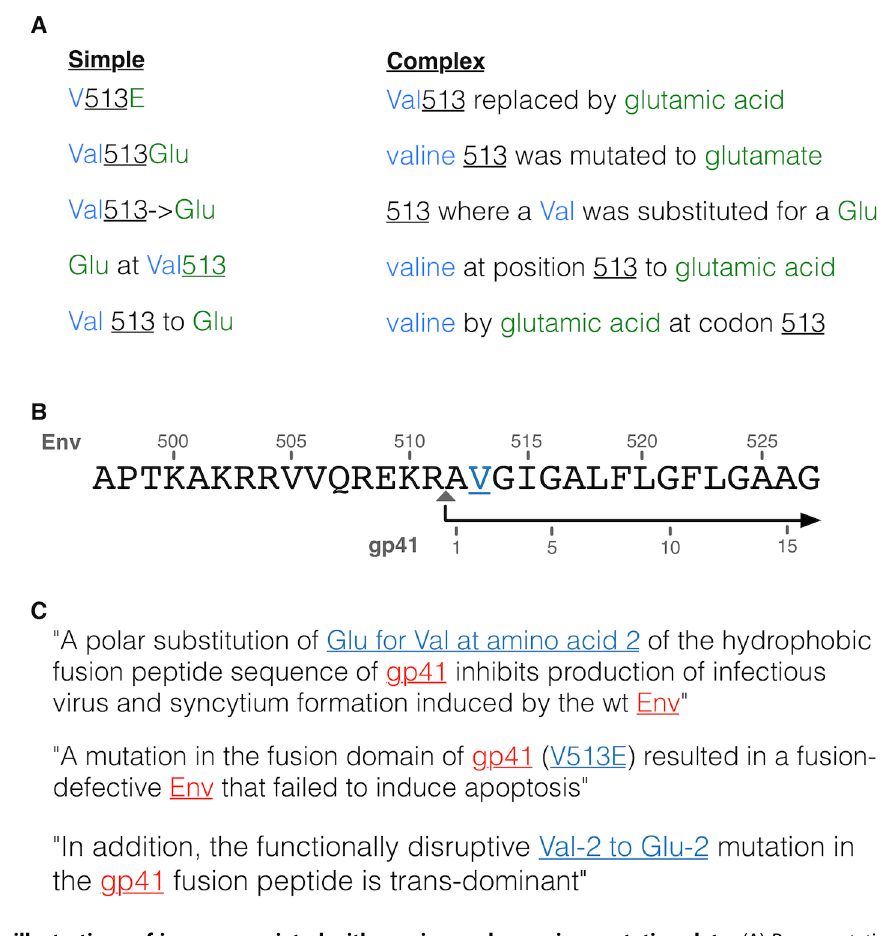
Figure 4. Example illustrations of issues associated with parsing and mapping mutation data. (A) Representative simple and complex examples of sentences recognised by the templates used to perform the mutation text-mining of articles (see Table S1 for complete list). Information of interest representing the wildtype residue (blue) and mutated residue (green) are coloured and position of the mutations are underlined. (B) Illustration of the distinct numbering schemes for different chains of the same protein. The shown peptide sequence is a short region (497–527) of the HIV Envelope glycoprotein gp160 (Env) overlapping the site cleaved by the host furin to produce the Surface protein gp120 and Transmembrane protein gp41 chains. The cleavage site is denoted by a grey triangle. The numbering above the sequence defines the position relative to the start of the gp160 protein and the numbering below the sequence defines the position relative to the start of the gp41 chain. (C) Examples of three sentences from the HIV literature where each article uses a different nomenclature or numbering scheme (blue) to describe the same mutation at the same site, Valine at residue 513 in the gp160 protein. Each article also refers to the protein by the chain name, gp41, rather than the name of the unprocessed protein, Envelope glycoprotein gp160 (Env), used for mapping in the HIV mutation resource. One example sentence refers to the gp41 chain while utilising the numbering for the unprocessed protein.